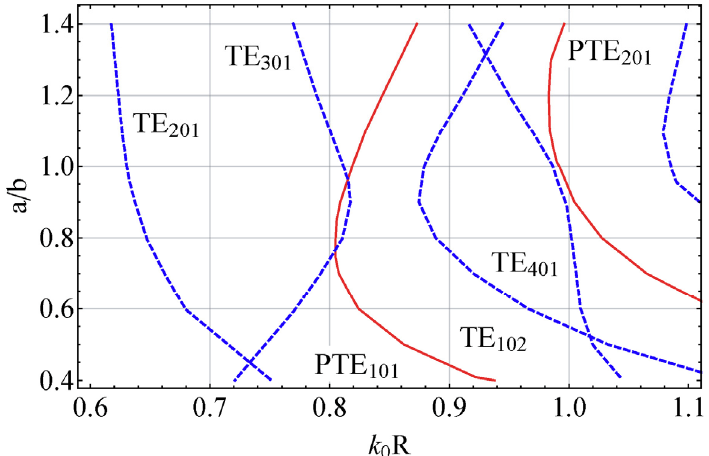
Figure 10. Perfect nonradiating TE modes of spheroids with ε = 50 as a function of the size parameter k 0 R and the aspect ratio, a/b . Red curves stand for TE perfect nonradiating modes (PTE) and blue dashed lines correspond to usual quasinormal TE modes.